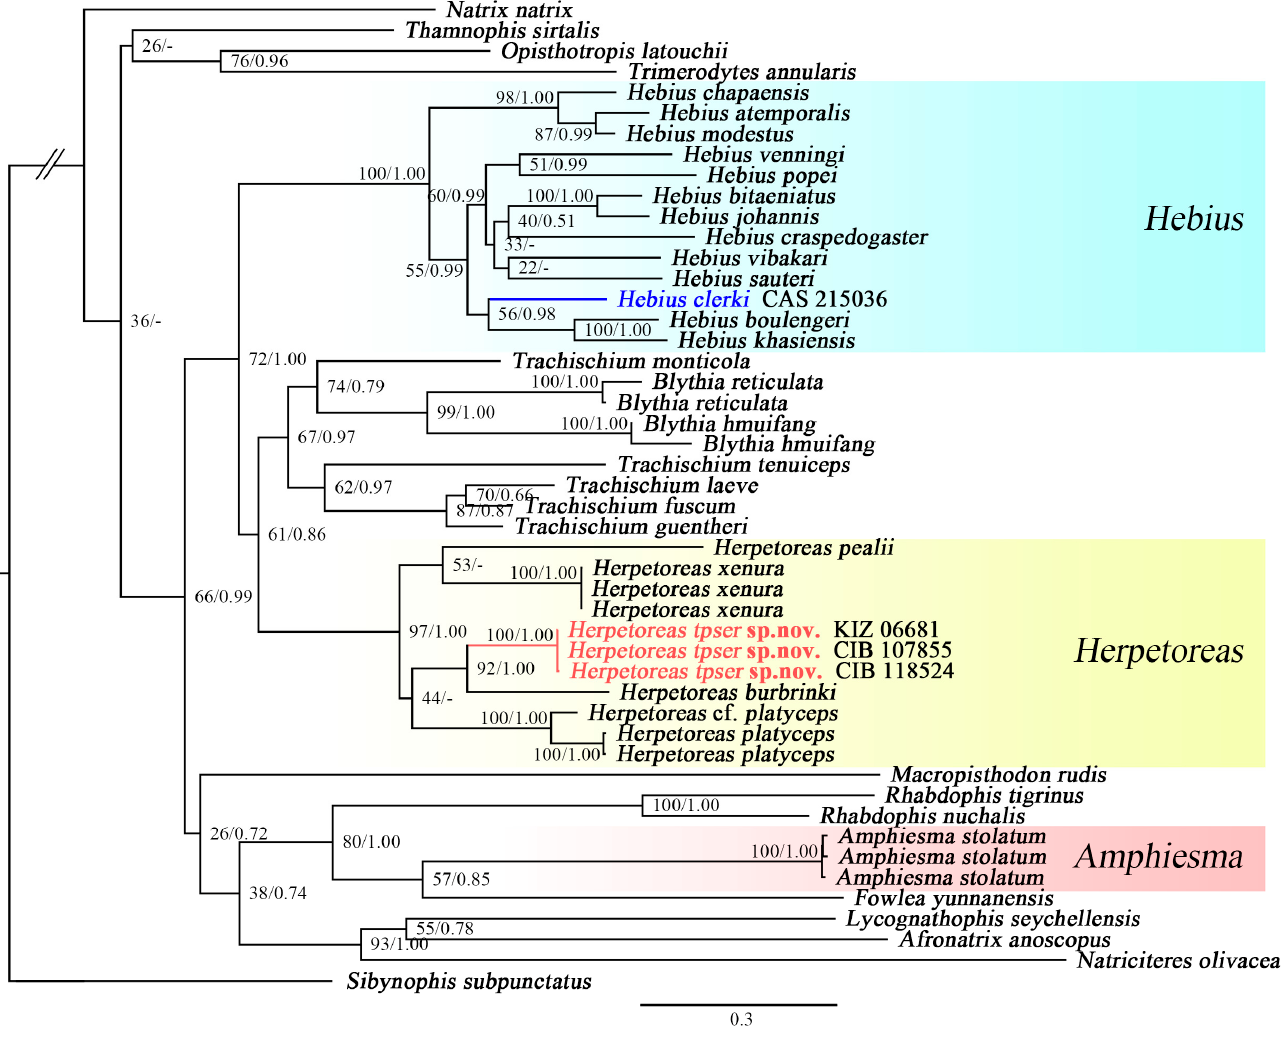
Figure 1. Maximum likelihood (ML) phylogenetic tree inferred from mtDNA Cyt b , 16S, and nuDNA gene CMOS , depicting phylogenetic relationships of Herpetoreas and related genera in Natricidae. Numbers above branches are bootstrap proportions and Bayesian posterior probability (BSP/BPP), respectively. “ ‐ ” indicates different topologies between Bayesian inference phylogenetic tree and ML tree.